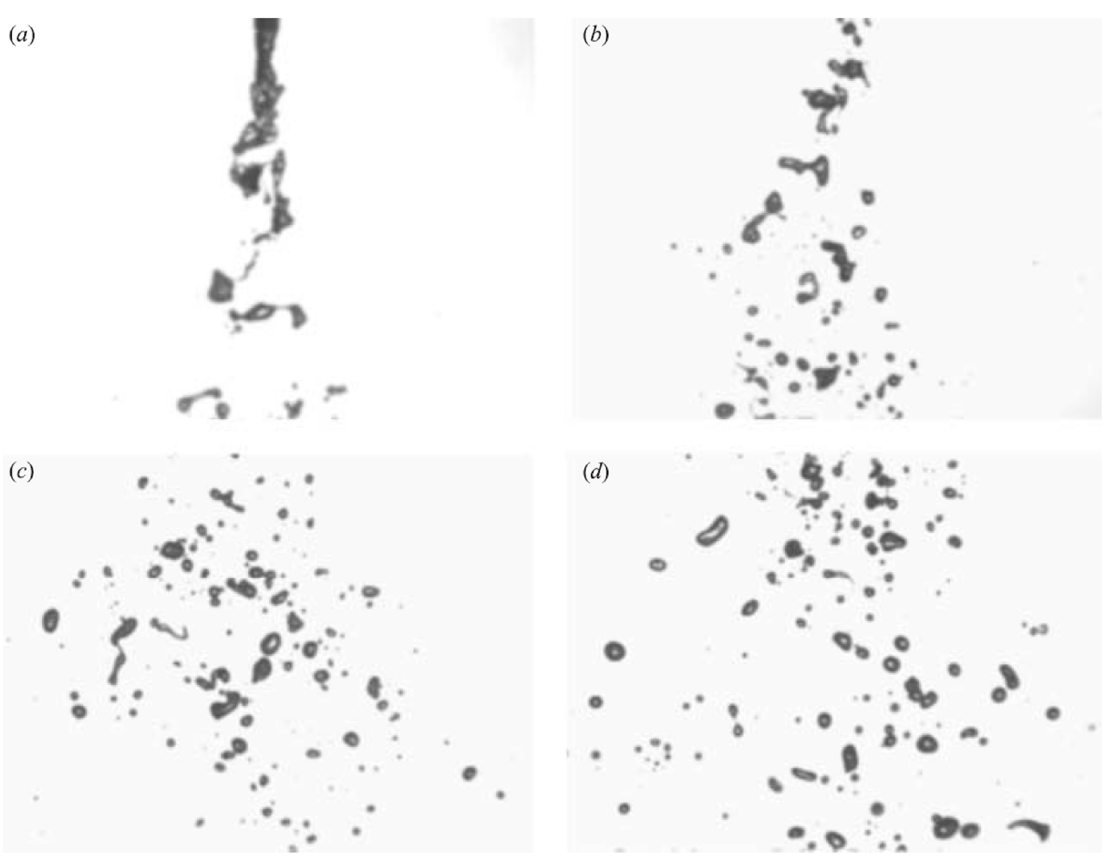
Figure 4. Example of a high-speed breakup visualization sequence (from ref. [11]), showing a disperse fluid jet injected into a stationary liquid at different downstream positions ( a – d ). Reproduced with permission from [11]; Cambridge University Press, 2004.